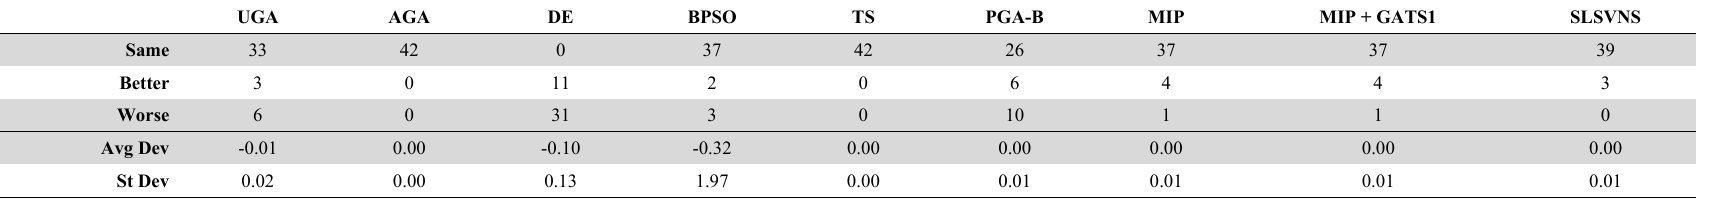
Summary statistics for solutions for Proposed Approach to compared Algorithm / Heuristic ( t i / p i >